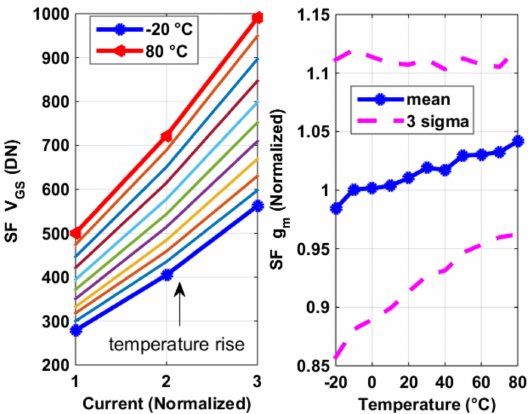
Figure 9. Measurement results of the SF g m , SF ’s temperature dependency ( left ), with constant g m biasing ( right